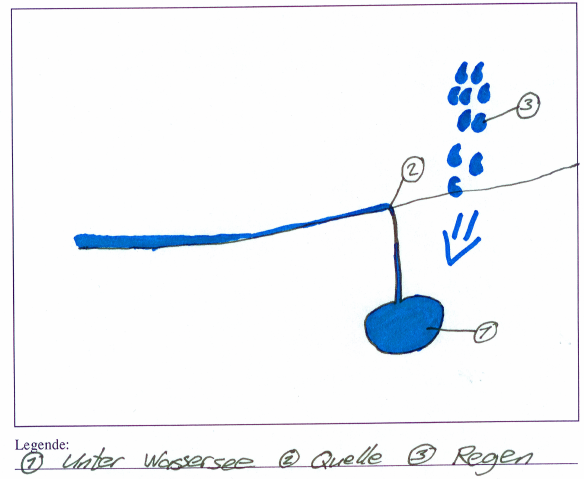
Fig. 1. Drawing of student 041F (boy, 14yr old). Legend: 1=sub(terranean) lake, 2=spring,